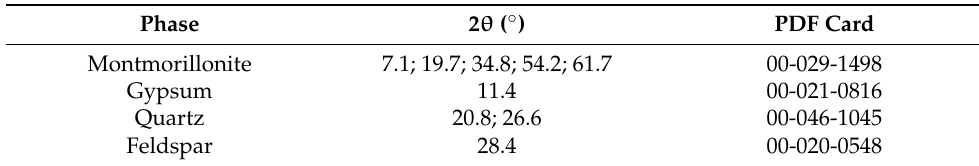
Figure 4. X-Ray diffractions of solids. Figure 4. X-ray diffractions of solids. Table 3. Phase assignment to the diffractogram